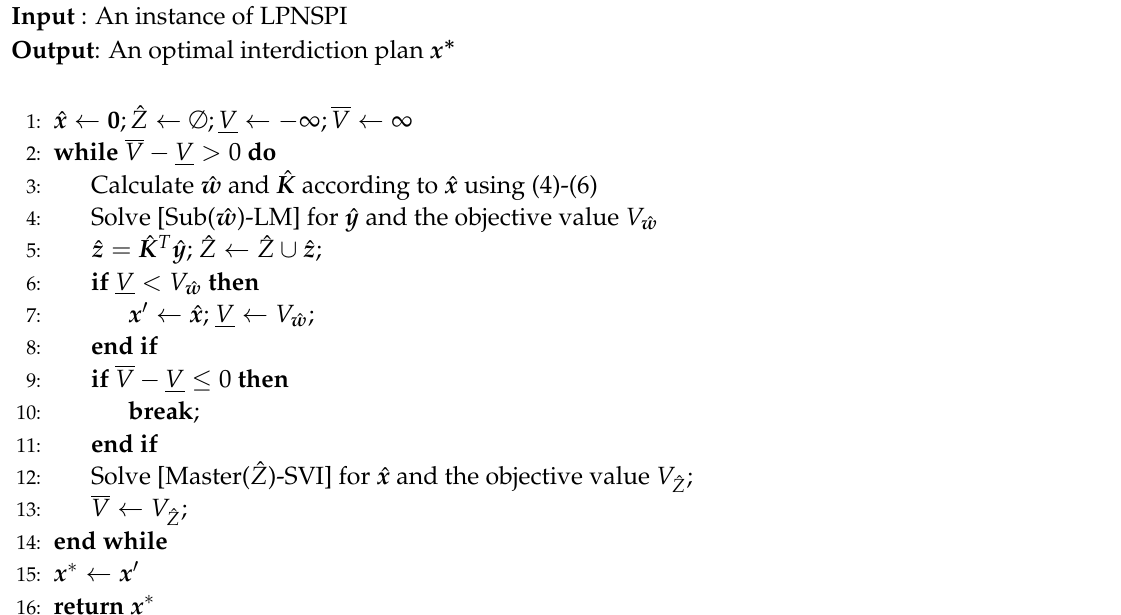
Algorithm 1 Basic Benders decomposition algorithm for